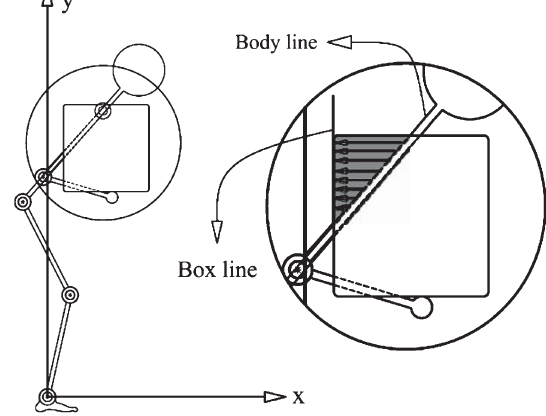
Fig. 5. Penetration of the box with the body, box line, body line and penetration aria.